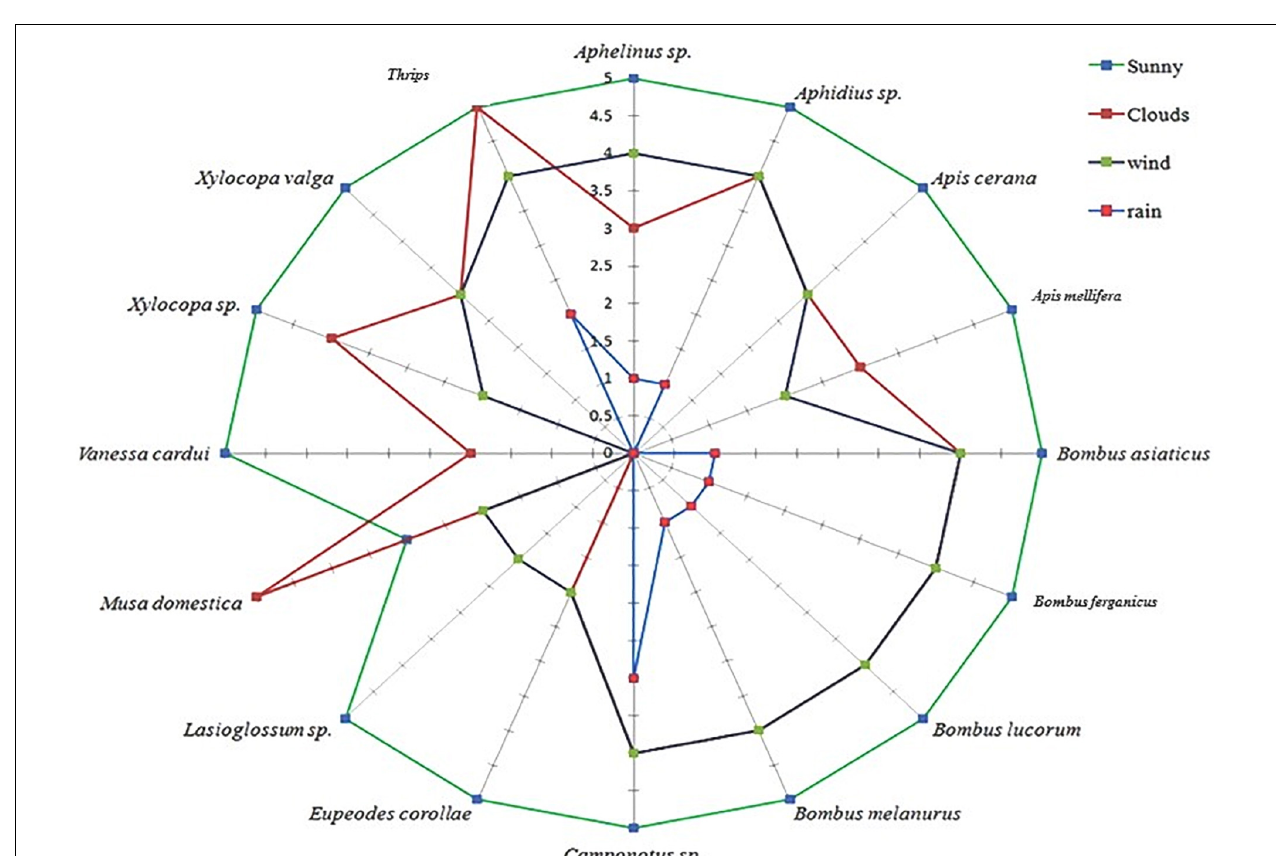
FIGURE 10 | Change in the pollinator visiting frequency during different weather